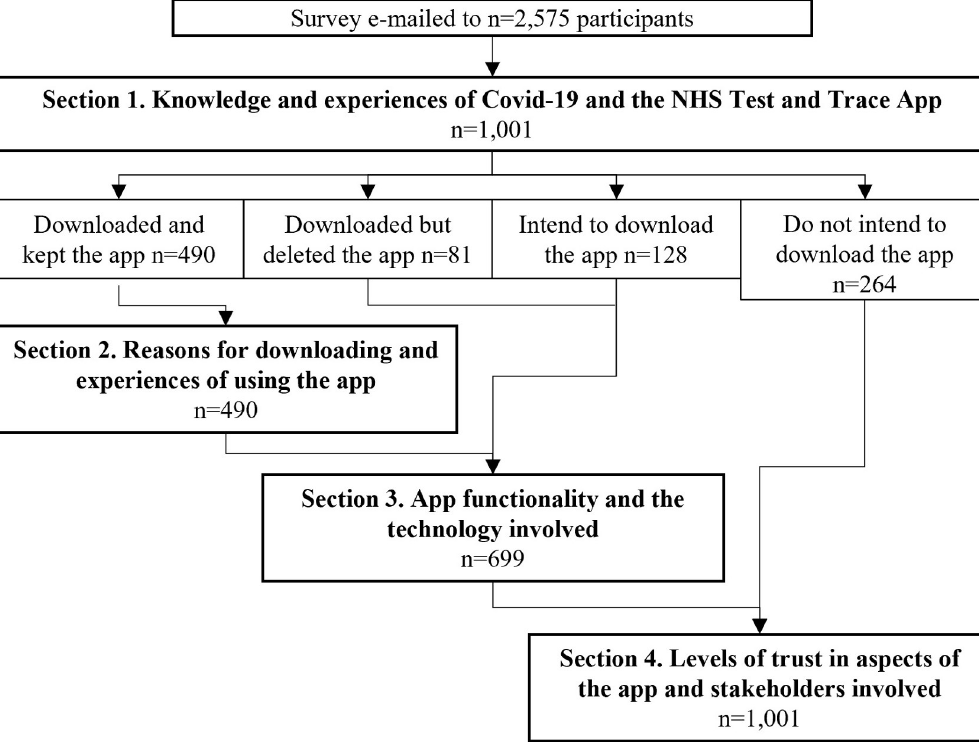
Fig 2. Survey flow and branching of participants. Specific questions/statements are reported in the